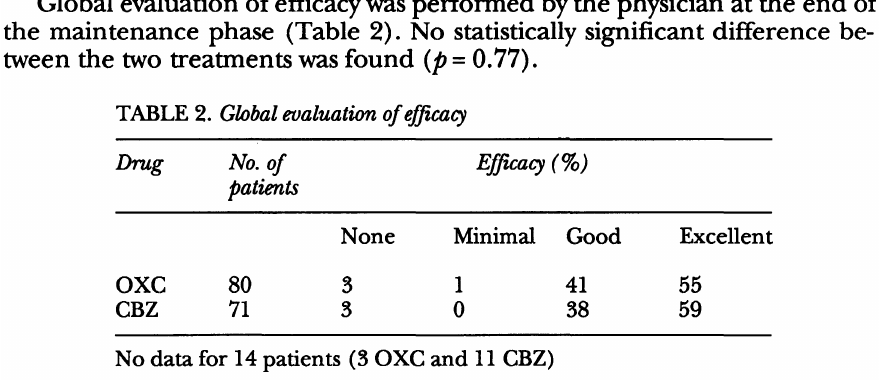
TABLE 1. Number of seizures/month before and during treatment with oxcarbaupine (OXe) and carbamaupine (CBZ) Drug No. of Number of seizures of patients Baseline Maintenancephase Mean SD Median Range Mean SD Median Range axc 83 2.9 7.0 1 ().6() 0.4 3.0 0 0-27 CBZ 82 5.8 14.7 0-12